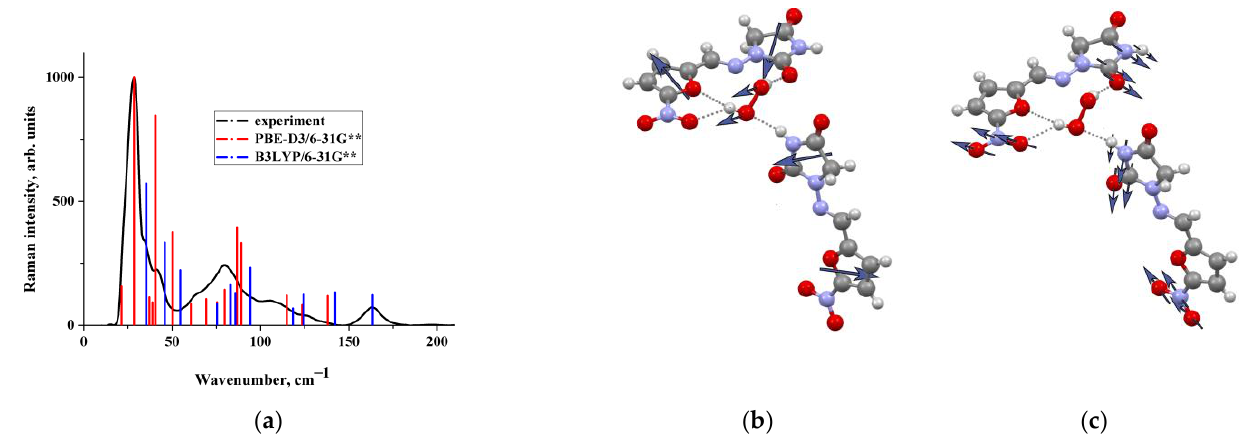
Figure 4. The experimental (black line) and calculated (PBE-D3 — red sticks and B3LYP — blue sticks) low-frequency Raman spectra of the [NFA+H 2 O 2 ] crystal ( a ). The height of the bars is proportional to the relative Raman intensity of corresponding transition. The schematic representation of the atom displacements of the two Raman intense vibrations (PBE-D3/6-31G**) at 30 cm − 1 ( b ) and 80 cm − 1 ( c ).